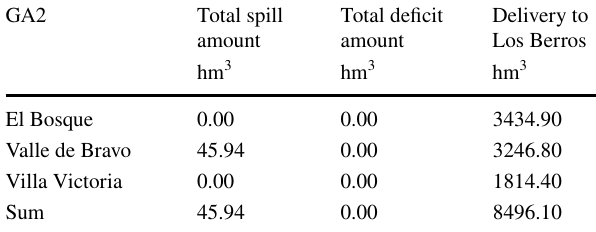
Table 7 Spills and deficits with genetic algorithm GA2 policy